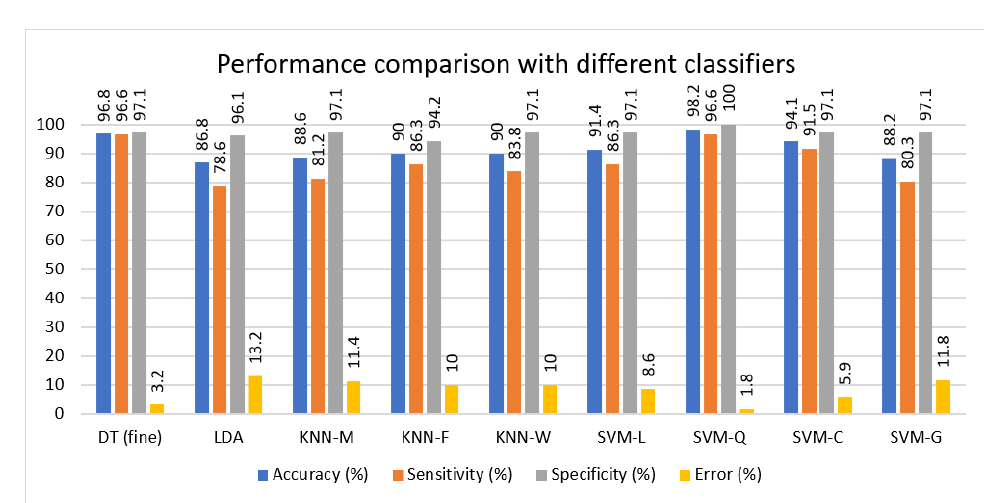
Figure 6. Performance comparison of different classifiers in terms of accuracy, sensitivity, specificity, and